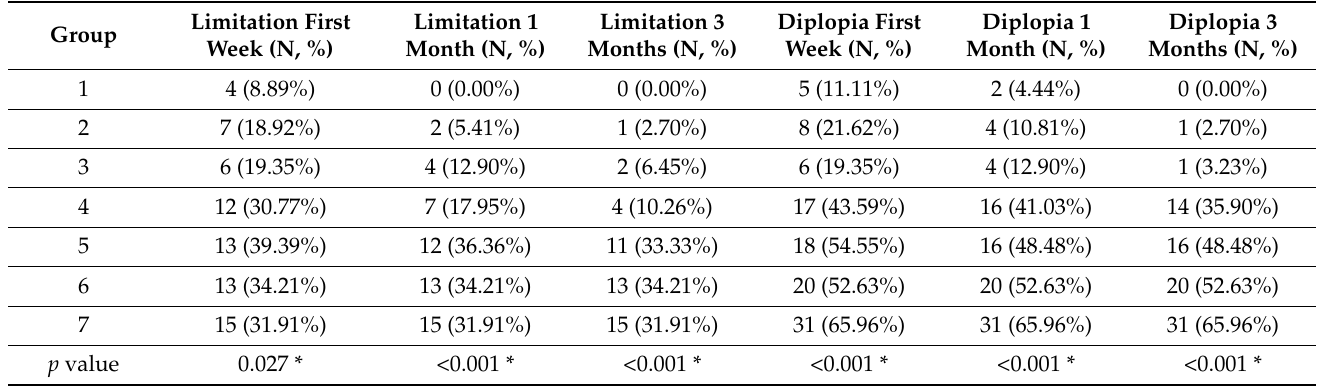
Table 2. Comparison of postoperative ocular limitations and diplopia.